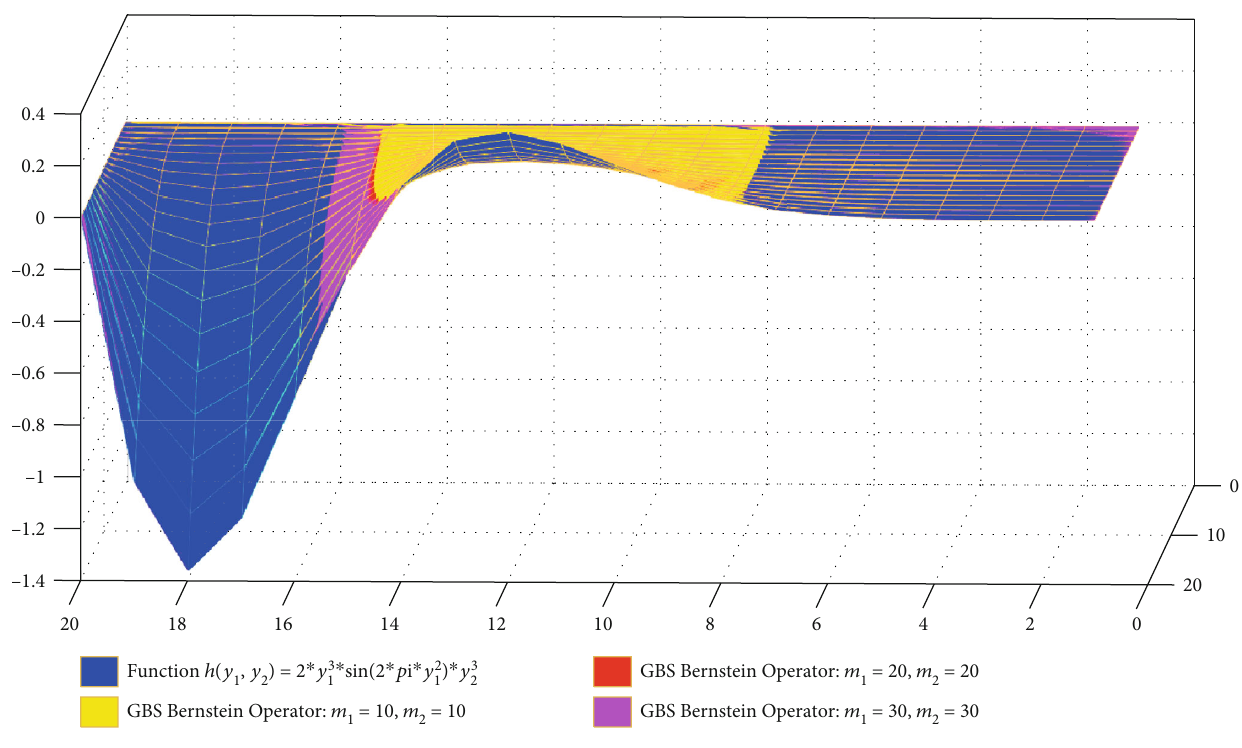
; y , y to h ð y , y 1 2 Þ 1 2 Þ